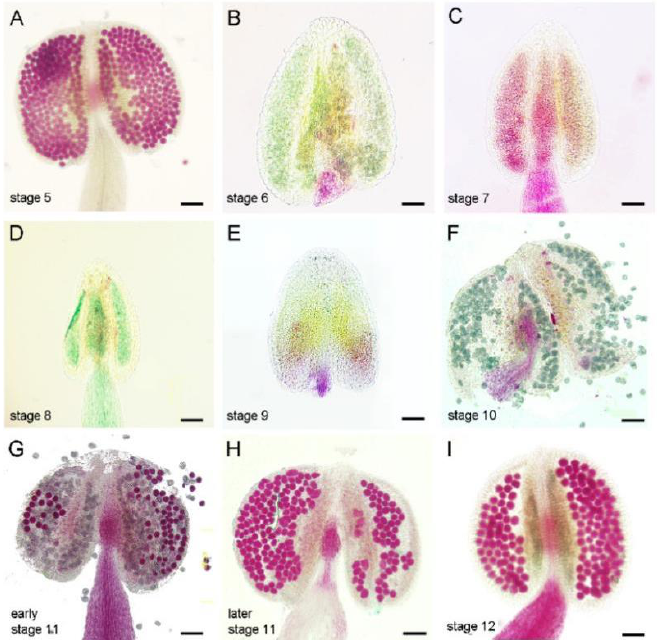
Figure 2. Alexander staining of anthers after 24 h of ethylene treatment. ( A – I ) Alexander staining of stage 5 to stage 12 anthers after 24 h treatment with ethylene (100 µL L −1 ). Bars = 50 µm. After ethylene treatment, plants were transferred to normal condition for further growth. The flower buds in the inflorescence gradually mature, and Alexander staining was carried out to stain the anthers of each mature flower.